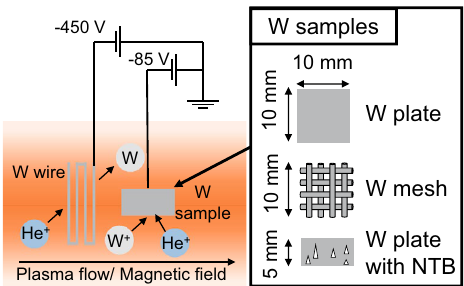
Figure 1. A schematic diagram of the experimental setup.